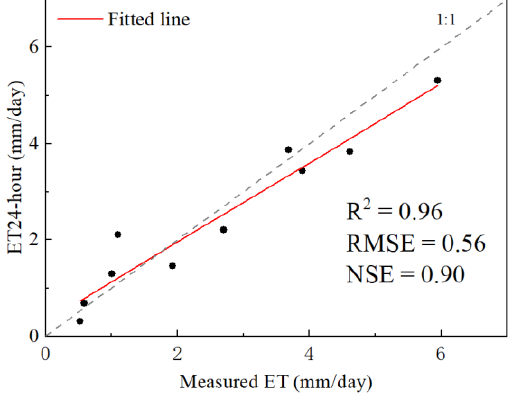
Figure 9. Validation of the estimated ET 24-hour .